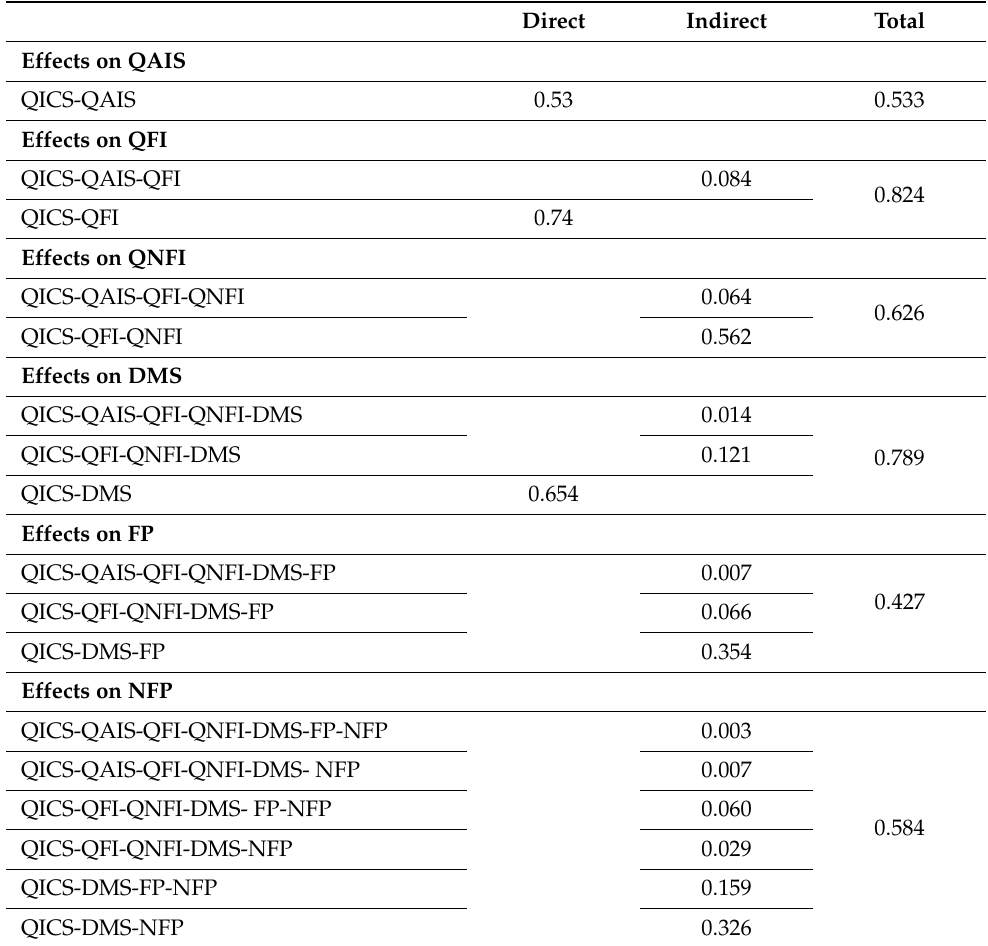
Table 5. Direct, indirect, and total